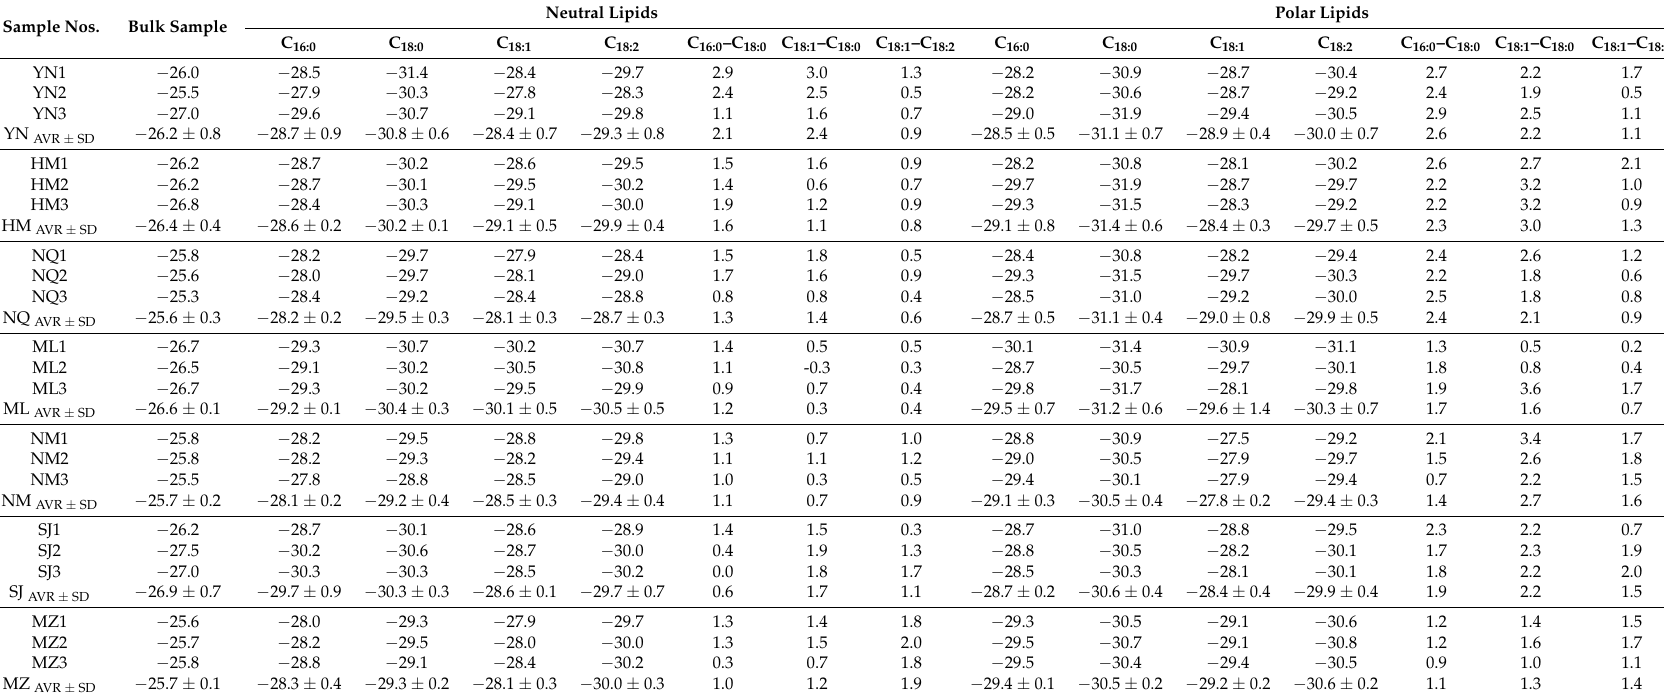
Table 2. δ 13 C values * ( ‰ ) of individual major fatty acids in neutral and polar lipids from Ophiocordyceps sinensis. Sample